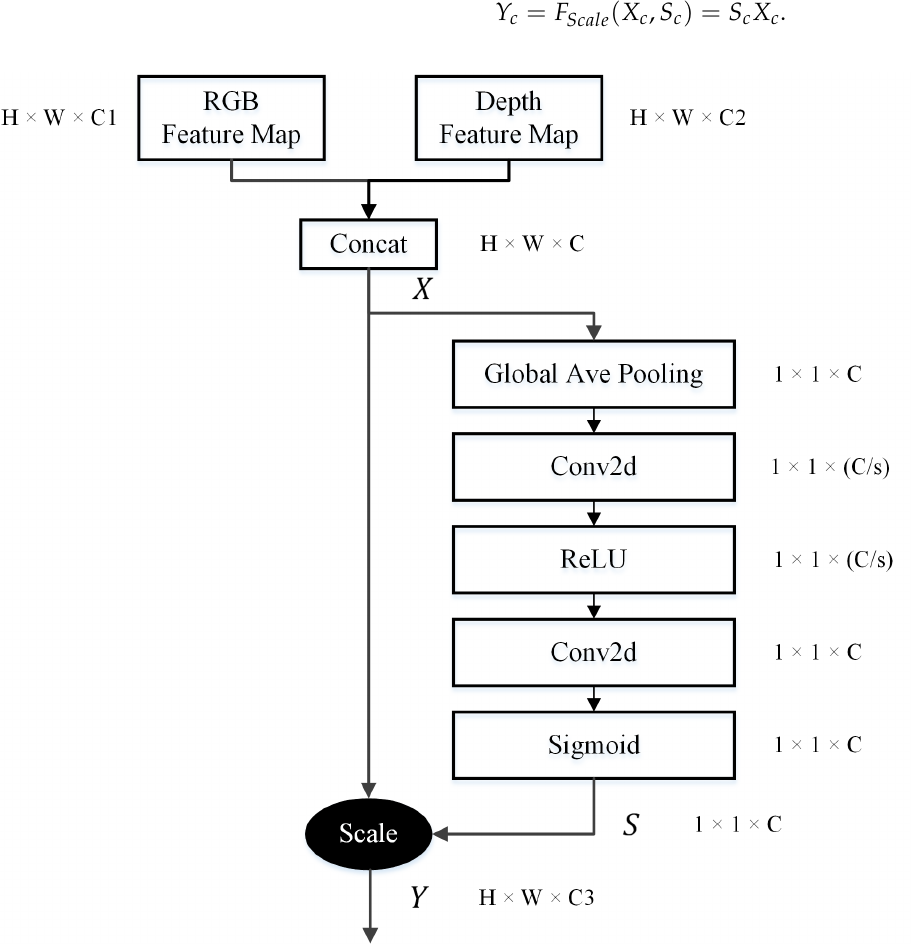
Figure 5. The structure of the Adaptive Channel Weighting (ACW)